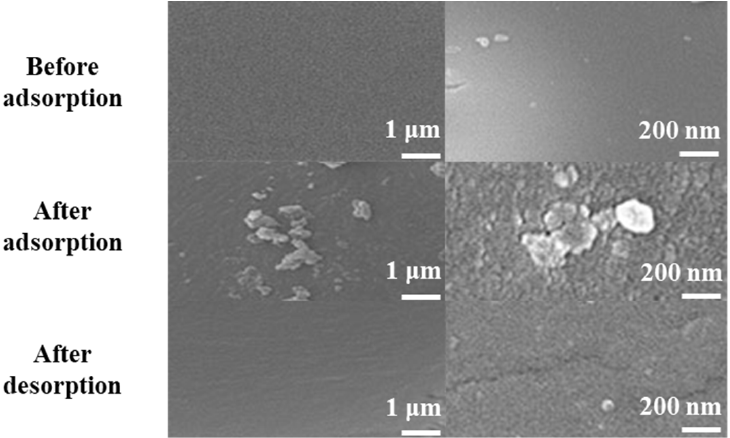
Figure 13. SEM characterization of PILs before adsorption, after adsorption and after desorption.